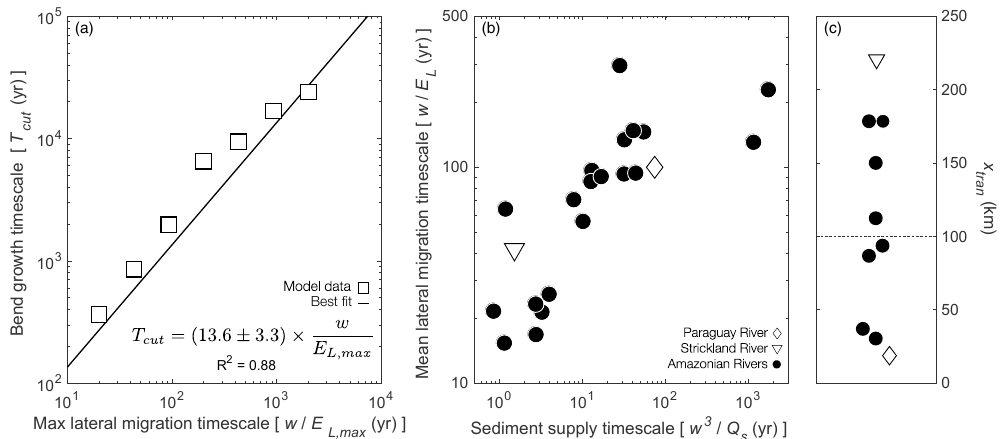
Figure 2. Sediment transport parameters in the model and field data. (a) The results of the numerical meandering model simulations that show that the meander bend growth timescale ( T cut ) is correlated with the time required for the channel to migrate one channel width at the maximum lateral migration rate ( E L , max ). (b) Field evidence (Aalto et al., 2008; Grenfell et al., 2012; Constantine et al., 2014) for a correlation between the mean time required to migrate one channel width ( w/E L ) and the sediment supply timescale ( w 3 /Q s ). (c) Jitter plot of calculated x tran values (Eq. 4) for the field data shown in (b) . Together, these panels show that T cut scales with the lateral migration rate, which, in field data, is correlated with suspended sediment fluxes (Constantine et al., 2014). The correlation between lateral migration rates and sediment fluxes results in minimal variation in the transport length scale and provides a proxy for T cut (i.e., w 3 /Q s ) for rivers where lateral migration rates are